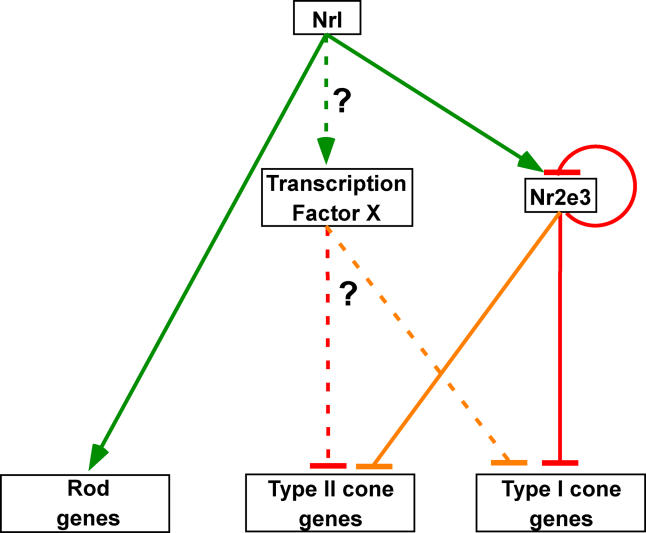
A Partial View of the Rod Photoreceptor Transcriptional Regulatory NetworkNote that green lines indicate activation, and yellow and red lines indicate weak and strong repression, respectively. The dotted lines associated with a question mark indicate that it is not known whether Nrl directly represses the target genes in question or whether its repression is mediated by a downstream transcription factor (“X”). Note that Nr2e3 appears to negatively regulate its own transcription. The regulatory linkages depicted in this diagram are not necessarily direct. The weak activation of some rod-specific genes by Nr2e3 is omitted from this diagram for clarity. Also not shown is the role of other photoreceptor transcription factors, such as Crx.